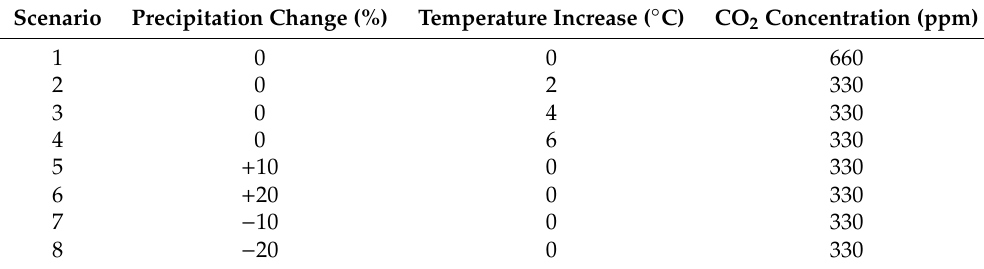
Table 6. Climate sensitivity